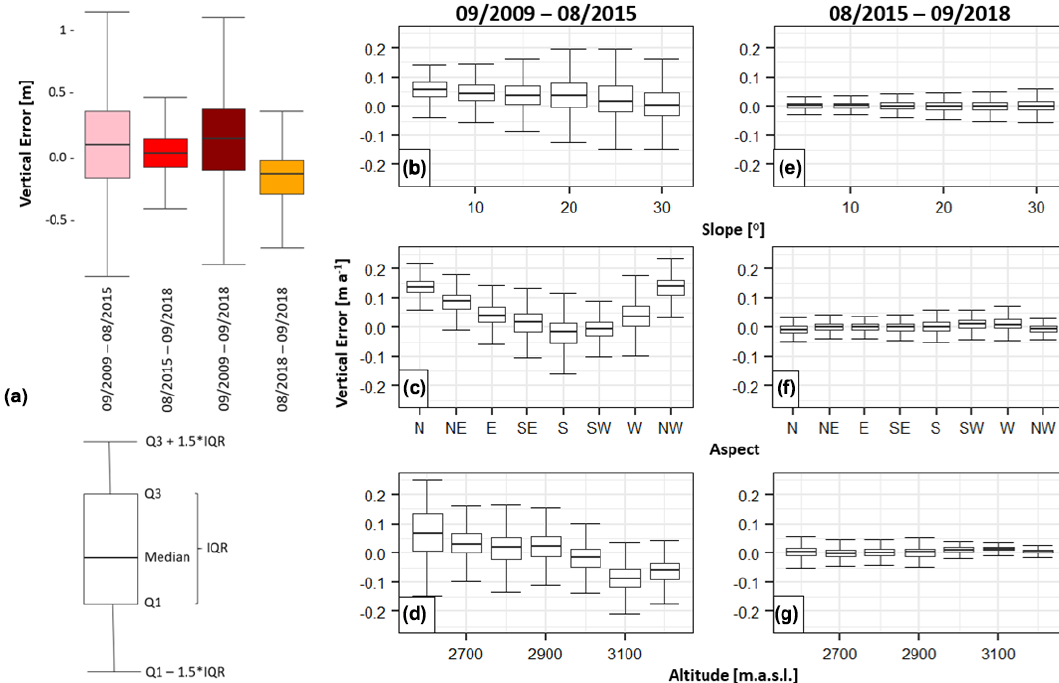
Figure 6. Overall vertical error of the DSM differences (a) ; annual vertical error for the periods September 2009–August 2015 (b–d) and August 2015–September 2018 (e–g) in relation to slope (b, e) , aspect (c, f) , and altitude (d, g) .